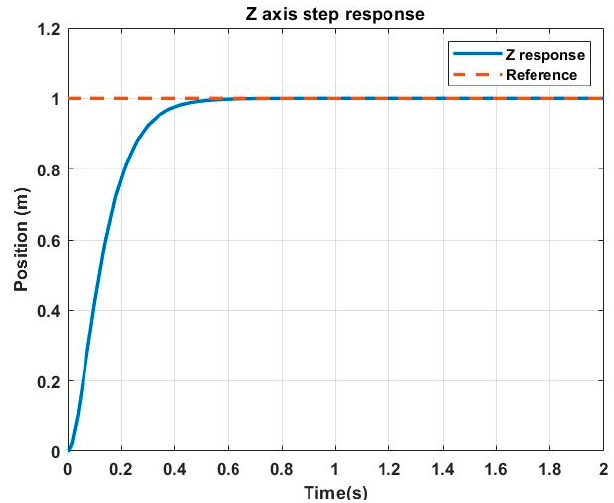
Figure 7. System response in 𝑍 axis.